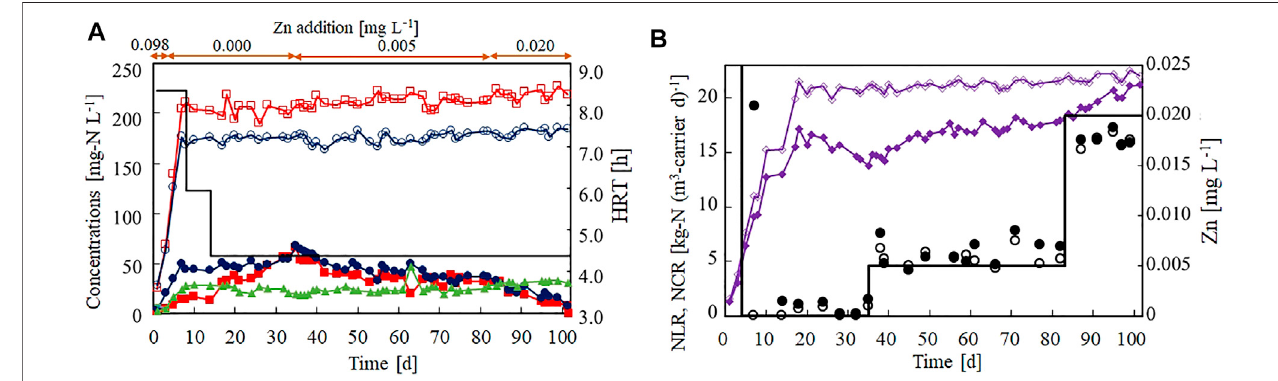
FIGURE 3 | Effect of Zn(II) concentration on the nitrogen removal performance of the anammox reactor. (A) Time courses (in days) of in fl uent ammonium (open circles), in fl uent nitrite (open squares), ef fl uent ammonium ( fi lled circles), ef fl uent nitrite ( fi lled squares), and ef fl uent nitrate ( fi lled triangles). The bar graph shows the hydraulic retention time on each day. (B) Time courses of nitrogen loading (open diamonds) and nitrogen conversion rate ( fi lled diamonds).The bar graph shows the set value of the in fl uent Zn(II) on each day. The open and closed circles indicate the in fl uent and ef fl uent Zn concentrations, respectively.